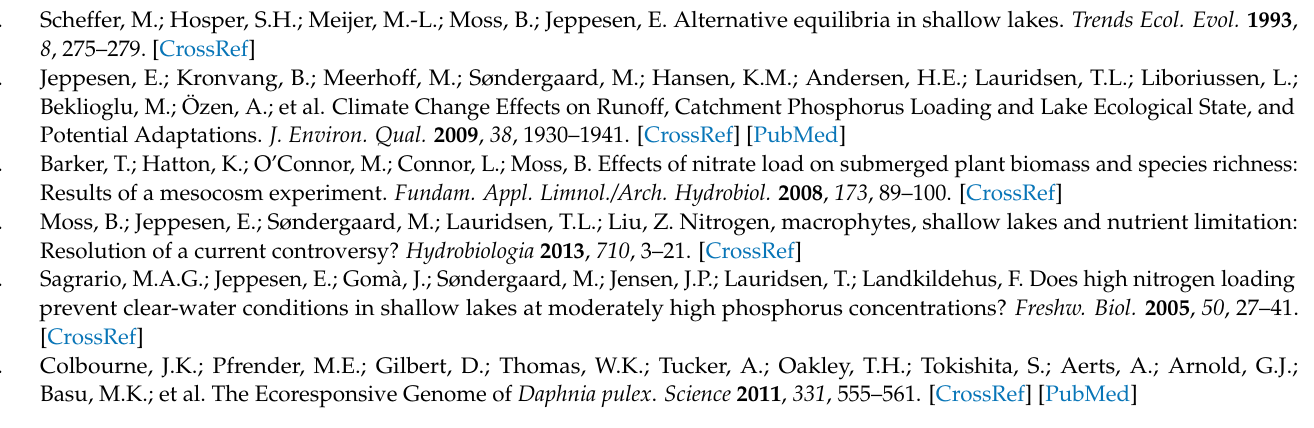
S2: Hedges’ g effect sizes calculated from the F-statistic; Figure S3: Stressor effects on macrophytes in the micro- and mesocosms; Figure S4: Microcosms. Relative proportions of primary producers; Figure S5: Microcosms. Weekly measures of the absorbance of water at 663 nm; Figure S6: Mesocosms. Pesticide concentrations measured over 8 weeks; Figure S7: Biomass per volume of macrophytes and zooplankton:phytoplankton ratios in the micro- and mesocosms; Table S1: ARO concentrations and temperatures of micro- and mesocosms; Table S2: Starting size of biotic community in micro- and mesocosms; Table S3: Morphotypes used in the micro- and mesocosms; Table S4: Comparison